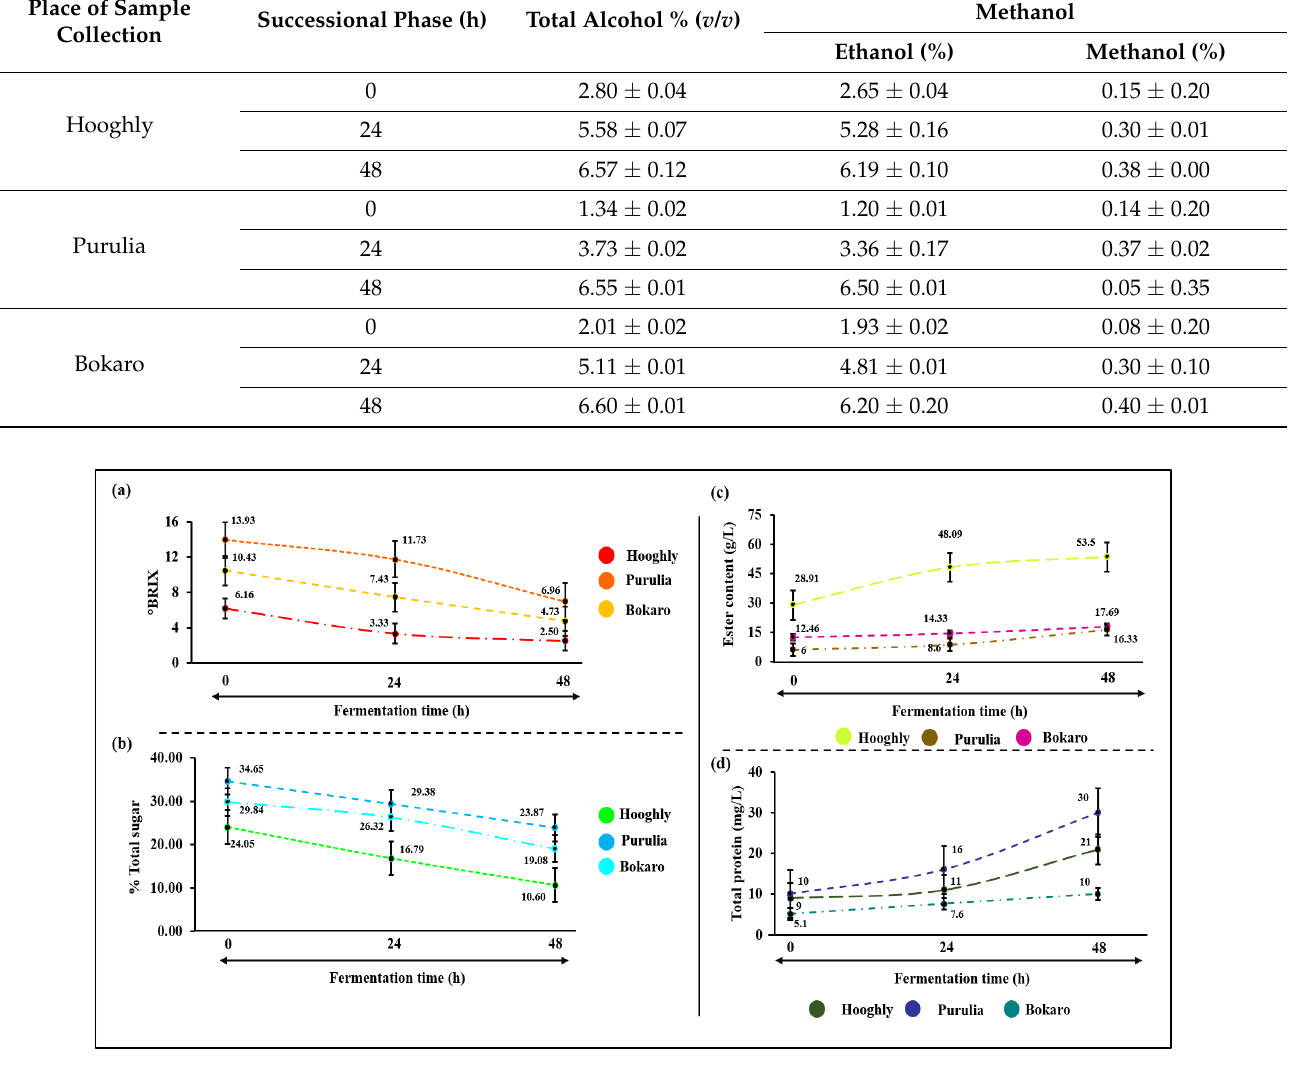
Figure 4. Phase-wise changes in ( a ) °BRIX content, ( b ) total sugar profile, ( c ) total ester content and ( d ) crude protein content, over the course of the natural fermentation of toddy .